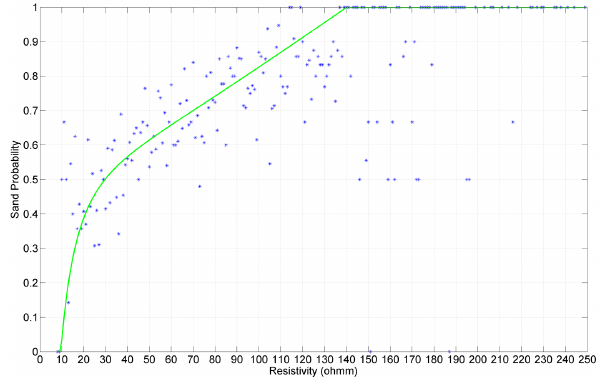
Figure 4: Non-linear regression of sand occurrence against SkyTEM data. Blue points are sand 2 Figure 4. Non-linear regression of sand occurrence against occurrence from borehole data compared to resistivity. The green line is the regression function 3 SkyTEM data. Blue points are sand occurrence from borehole data (Eq. (6)), coefficient of determination is 0.80 and RMSE is 0.08. 4 compared to resistivity. The green line is the regression function (Eq. 6), coefficient of determination is 0.80 and RMSE is